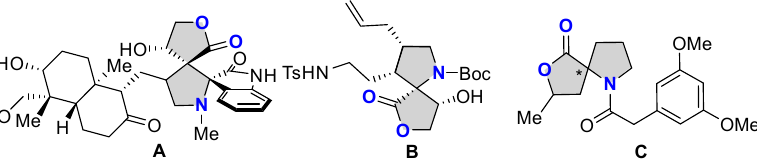
Figure 1. Selected bioactive compound and the key intermediate of nature products containing a chiral spirocyclic butyrolactone-pyrrolidine moiety as the structural